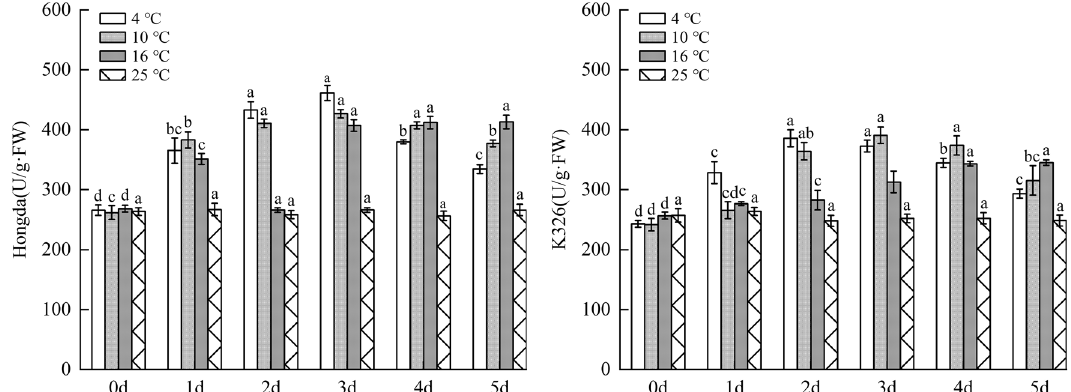
Figure 10. The changes of SOD activity in tobacco leaves under different low-temperature stresses. Different lowercase letters indicated that there were significant differences at different times under the same temperature treatment (P < 0.05).The values were the mean of three biological replicates.